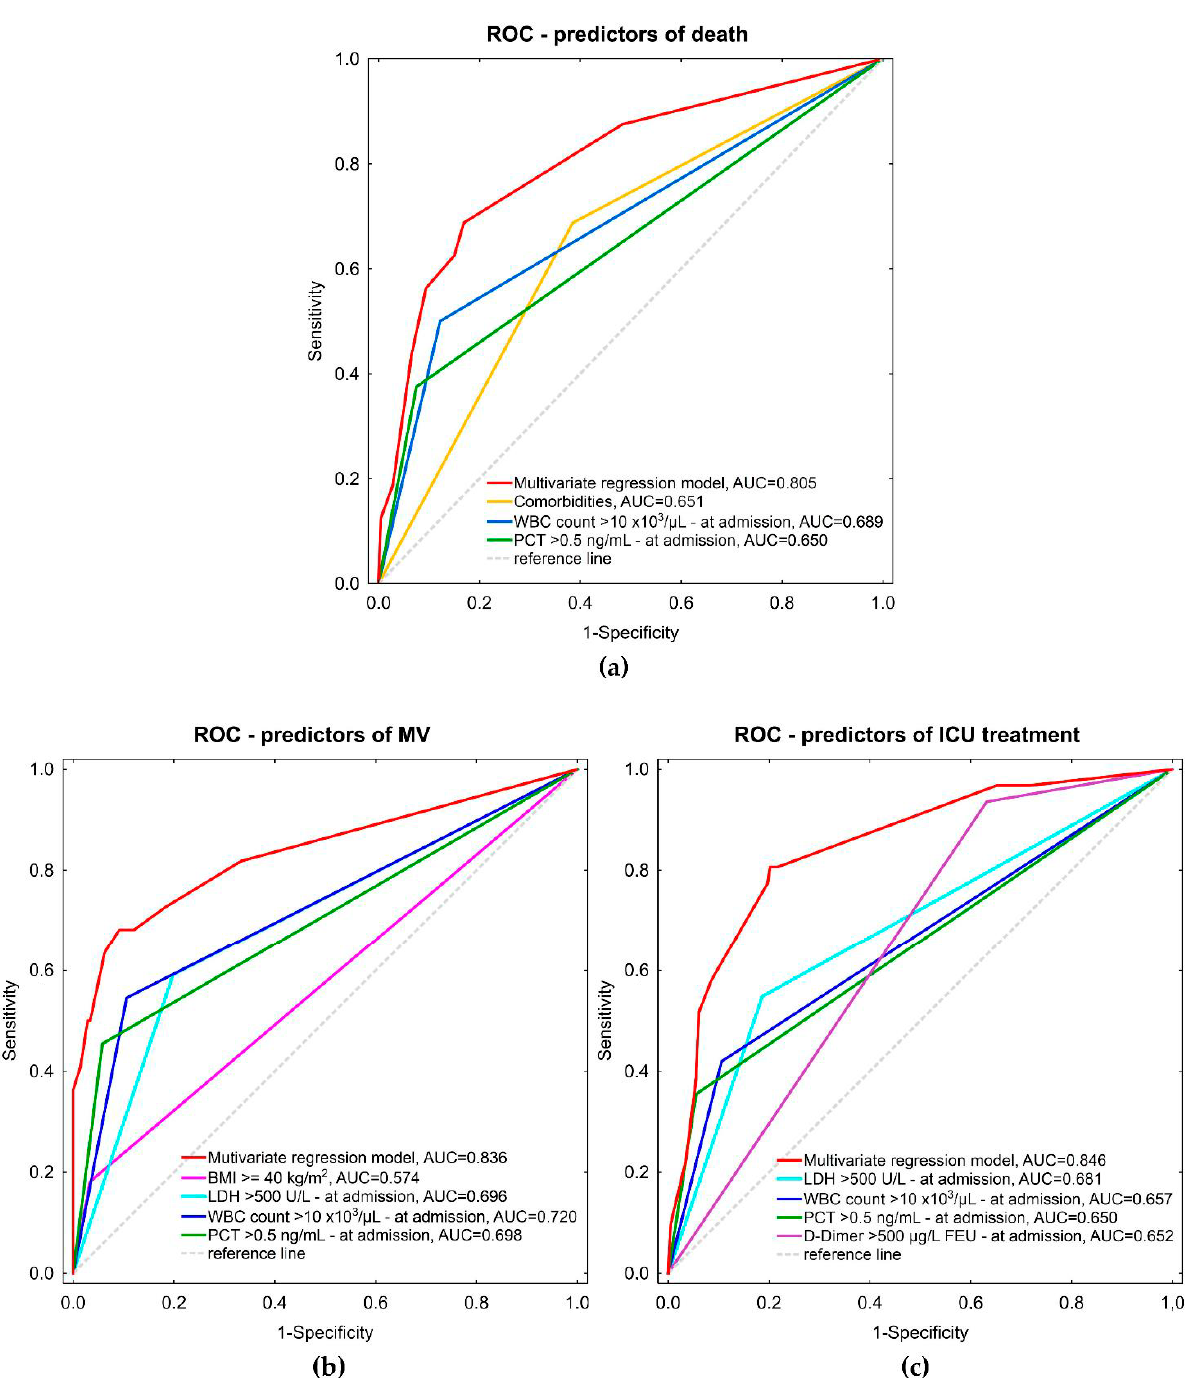
Figure 3. The receiver operating characteristic (ROC) curves with an area under the curve (AUCs) of individual factors and combined models in multivariate logistic regression analysis for predicting: ( a ) death; ( b ) MV; and ( c ) ICU treatment. Nominal data (including comorbidities) and categorized clinical and laboratory parameters obtained at admission and significant in univariate regression were included in this analysis. Comorbidities (AUC = 0.651), WBC count > 10 × 10 3 / μ L (AUC = 0.651), and PCT > 0.5 ng/mL (AUC = 0.650), were associated with death; BMI ≥ 40 kg/m 2 (AUC = 0.574), LDH > 500 U/L (AUC = 0.696), WBC count > 10 × 10 3 / μ L (AUC = 0.720), and PCT > 0.5 ng/mL (AUC = 0.698) were associated with MV, while D-Dimer > 500 μ g/L FEU (AUC = 0.652), LDH > 500